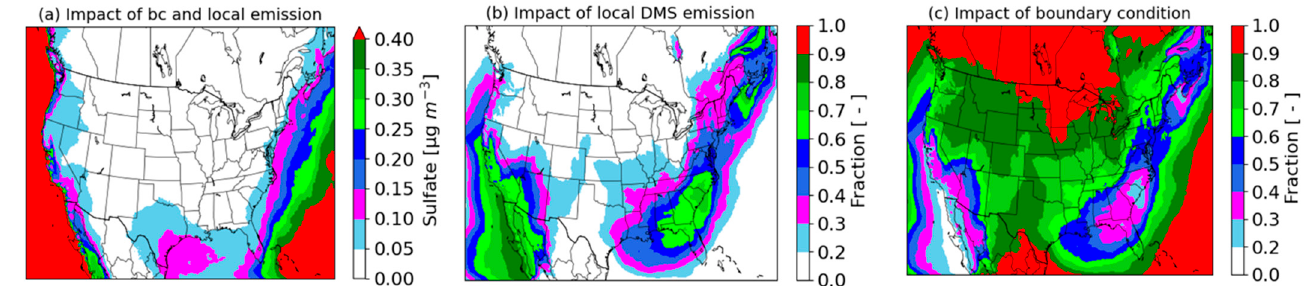
Figure 7. ( a ) Combined impact of DMS emissions and boundary conditions on sulfate, ( b ) fractional impact of within-domain DMS emissions on sulfate, and ( c ) fractional impact of outside-domain DMS emissions (speci fi ed through boundary conditions) on sulfate in July.